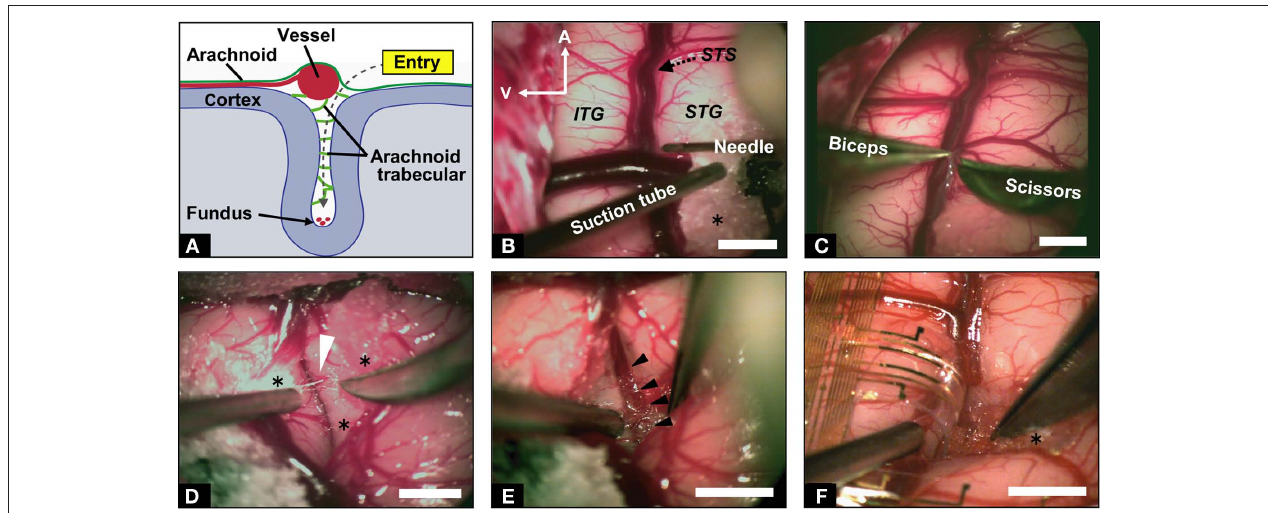
(C) Sharp cutting of the arachnoid membrane. (D) Exposure of trabecular connective tissues (white arrowhead) between the upper and lower banks of STS with careful retraction of the lower bank. (E) Observation of microvessels at the fundus of the STS (black arrowheads). (F) A branch of the electrocorticographic (ECoG) probe inserted into the sulcus. Approximately 7 mm of the probe was inserted in depth. Scale bars indicate